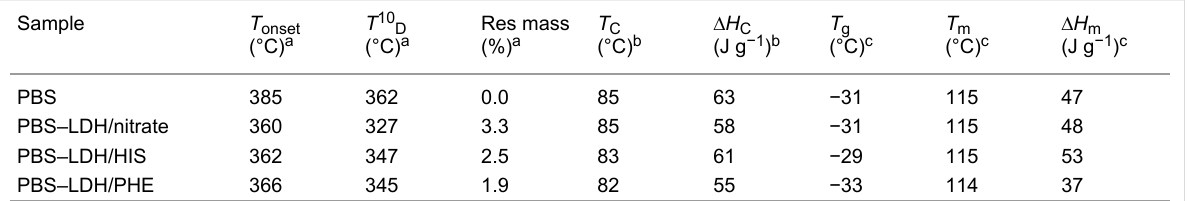
Table 2: Thermogravimetric and calorimetric data of PBS nanocomposites with 5 wt % of Mg 2 Al LDHs fillers.